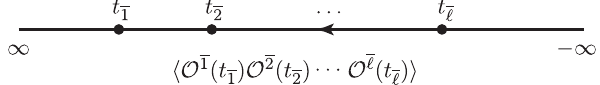
¯ l ¯1 O ; … ; O ¼ð O Þ , t ¼ð t ¯1 ; … ;t ¯ l Þ , and ω p p